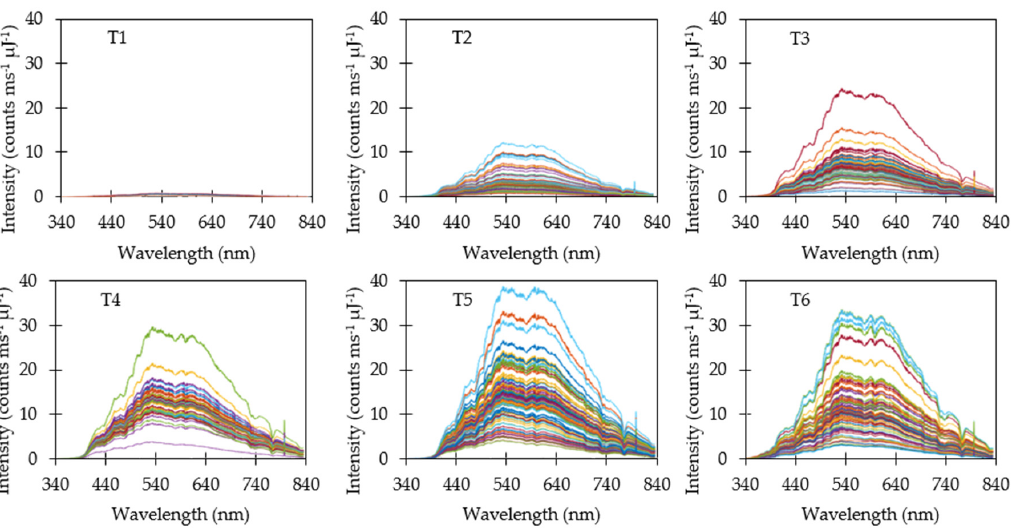
Figure 7. Normalized reflectance measurements divided by ambient light energy (M3).